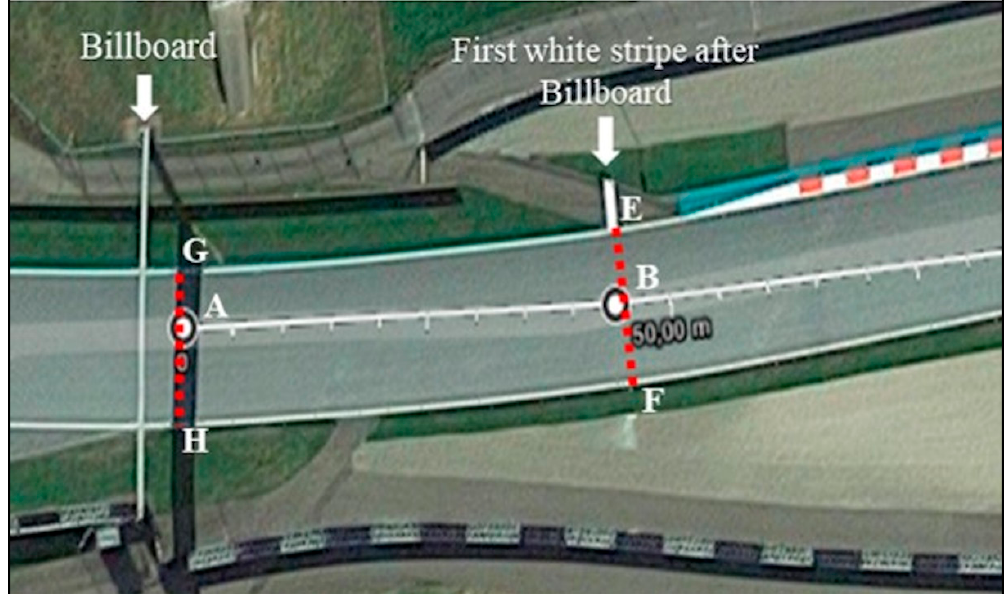
Figure 4. Satellite image showing the section of the straightaway before turn 3. The white arrows indicate a billboard and the first white stripe on the left side of the track (race direction). The red dashed lines were traced from point G to point H and from point E to point F. Points A and B indicate the crossing of the front wheel of Zarco’s bike, as well as the front wheels of the other riders under consideration. The distance from point A to point B measures 44.5 m.